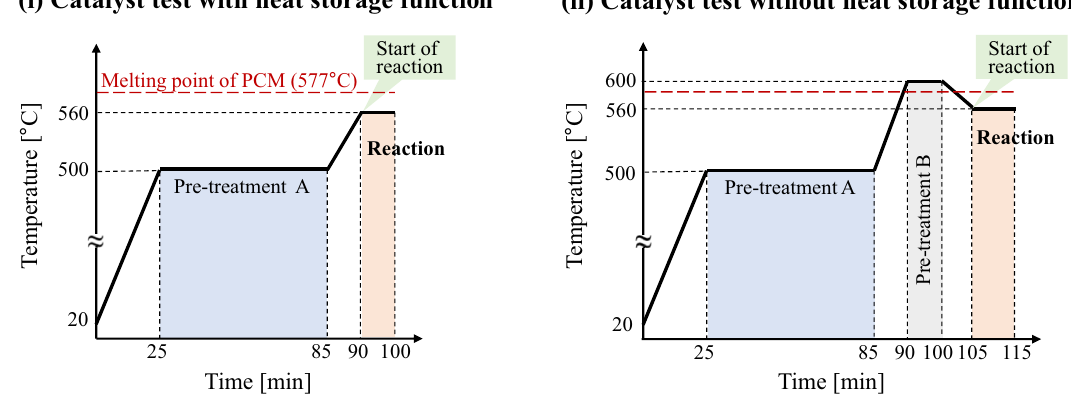
Figure 3. Temperature programs for measuring thermal control performance during the CO 2 methanation reaction of the Ni/MEPCM with/without a heat storage function. In the condition (i), internal PCM is solid and has the latent heat storage function when the catalytic reaction starts. In the condition (ii), internal PCM is liquid and does not have the latent heat storage function when reaction starts. Here, Pre-treatment ( A ) is reduction of NiO of the as prepared Ni/MEPCM under H 2 and Ar flow at 500 °C. Pre-treatment ( B ) is for loosing heat storage function of the Ni/MEPCM by maintain it at 600 °C for 10 min in Ar flow. CO 2 methanation reaction was started at 560 °C after Pre-treatment ( A ) or ( B